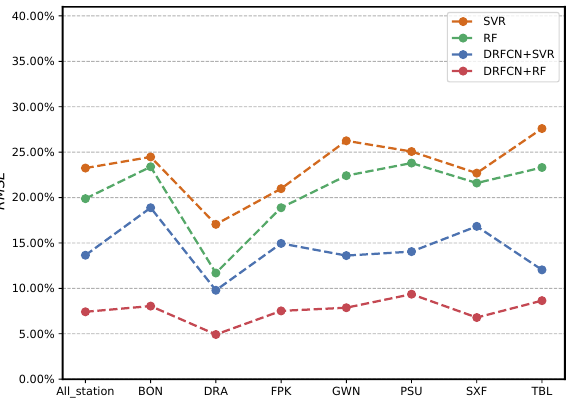
Figure 7. A line chart of comparison of the RMSE generated by DRFCN+RF vs. the DRFCN+SVR, RF, and SVR models.